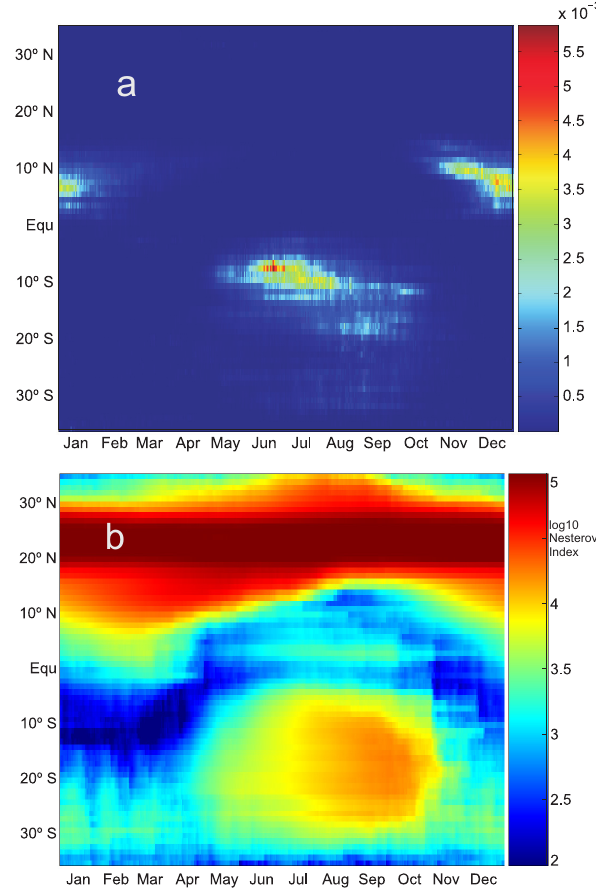
Fig. 6. Hovm¨oller diagram of remotely sensed daily ratio of burned area per day (a) and of daily latitudinal averages of the Nesterov in- dex based on the climate data, averaged over the period from 2000– 2008 (b) . The red areas between 20 ◦ N and 30 ◦ N in panel (b) are for the Saharan desert where the Nesterov index was never reset to zero (requires rain event > 3mm per day) during the study